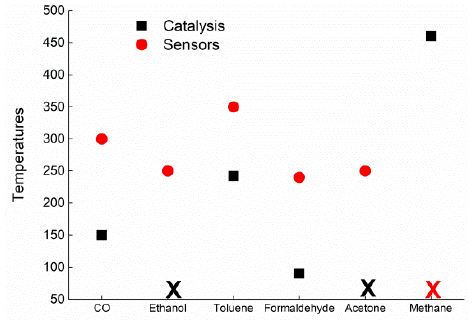
Figure 2. Best operating temperatures for the indicated sensing (best operating temperature and response tradeoff) and oxidation (lowest total combustion temperature) experiments over NiO materials. The crosses indicate the applications where no adequate references could be found. The references are reported in the discussion.